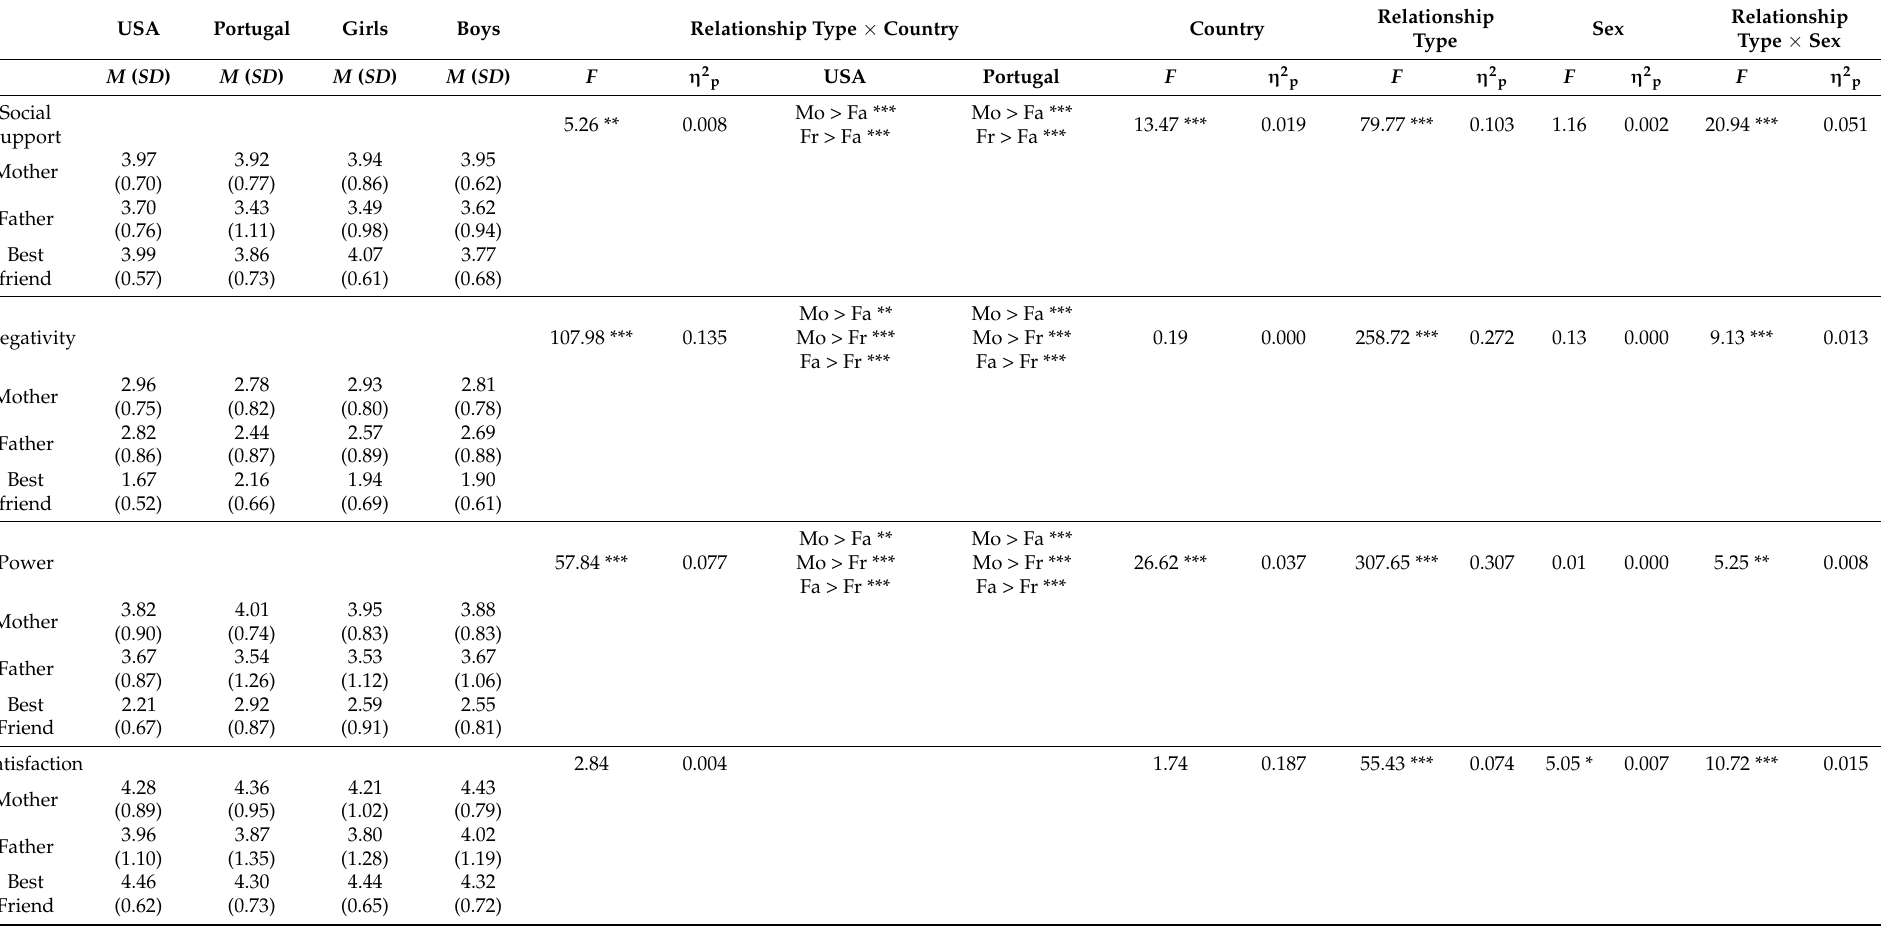
Table 1. Comparisons of the perceptions of relationship qualities and satisfaction with mothers, fathers and same-sex best friends, depending on country and sex. USA Portugal Girls Boys Relationship Type × Country Country